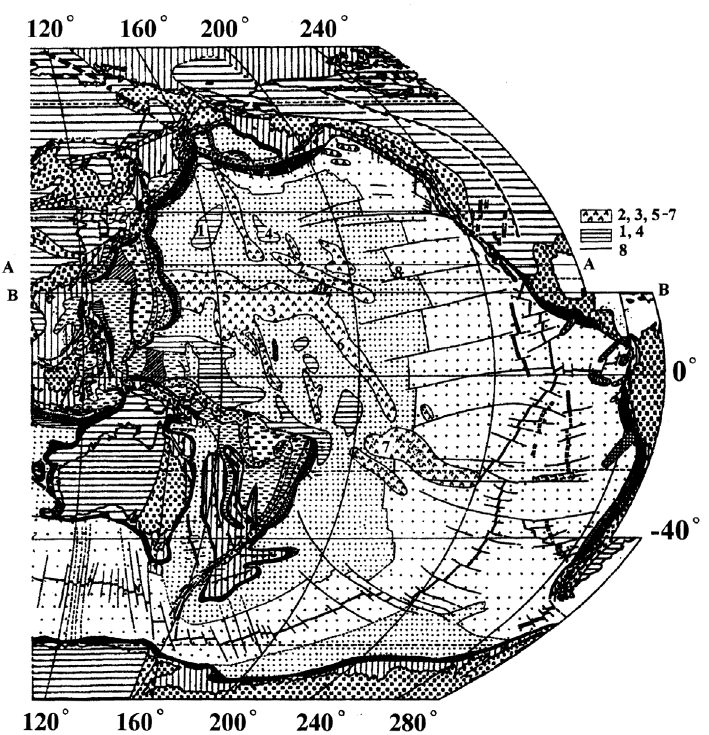
Fig. 4. Tectonic structure of the Pacific Ocean area presented in Sorokhtin (1979). Shaded tectonic areas are zones of uplifts with distribution of volcanic mountains. Uplifts: 1 – Shatsky; 2 – Hawaiian; 3 –